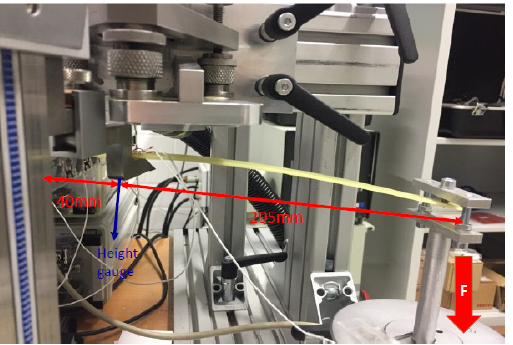
Figure 19. Experimental set-up used for evaluating the reliability of the residual stress measure- ments conducted.